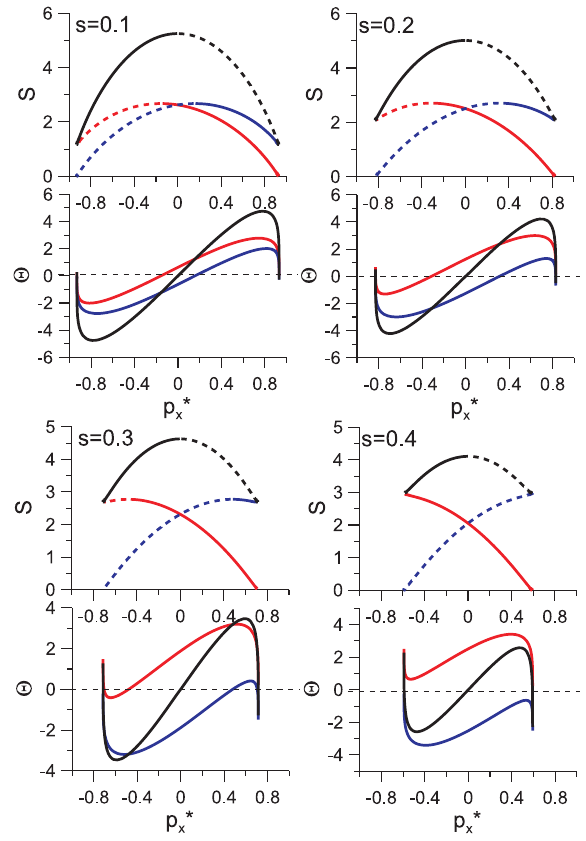
Fig. A3. Areas S l (red), S r (blue), S (black) and velocities 2 i are shown as functions of the parameter p ∗ x along the uncertainty curve for various s . Dotted segments of curves S i correspond to regions with 2 i <